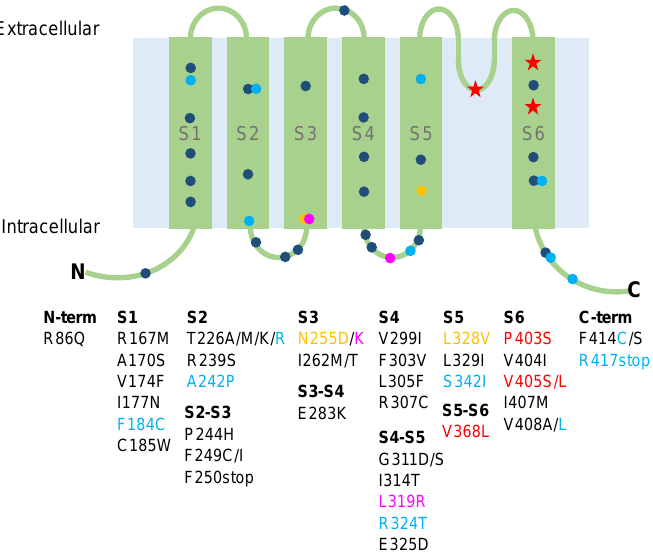
Figure 1. Cartoon showing the localization of the Kv1.1 identified mutations associated with episodic ataxia type 1 and epilepsy. Dark blue circles, mutations associated with episodic ataxia; magenta circles, mutations associated with paroxysmal kinesigenic dyskinesia; yellow circles, mutations associated with hypomagnesemia; light blue circles, mutations showing ataxia and epilepsy; red stars, mutations associated with epilepsy without